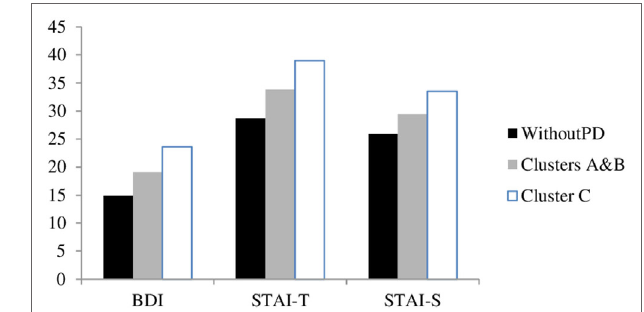
FigUre 1 | Anxiety and depression according to the instrument of